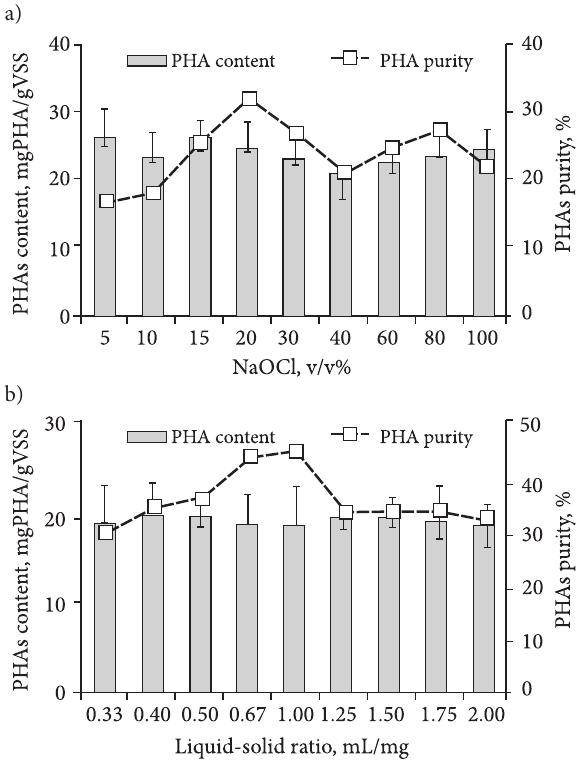
Figure 4. The optimum NaOCl concentration and L/S conditions of for extracting PHAs from sludge from the fermentation industry